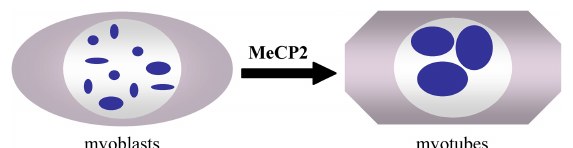
FIGURE 2 | Clustering of pericentromeric heterochromatin domains (chromocenters, blue spots) during myogenic differentiation of C2C12 myoblasts to myotubes (Brero etal.,